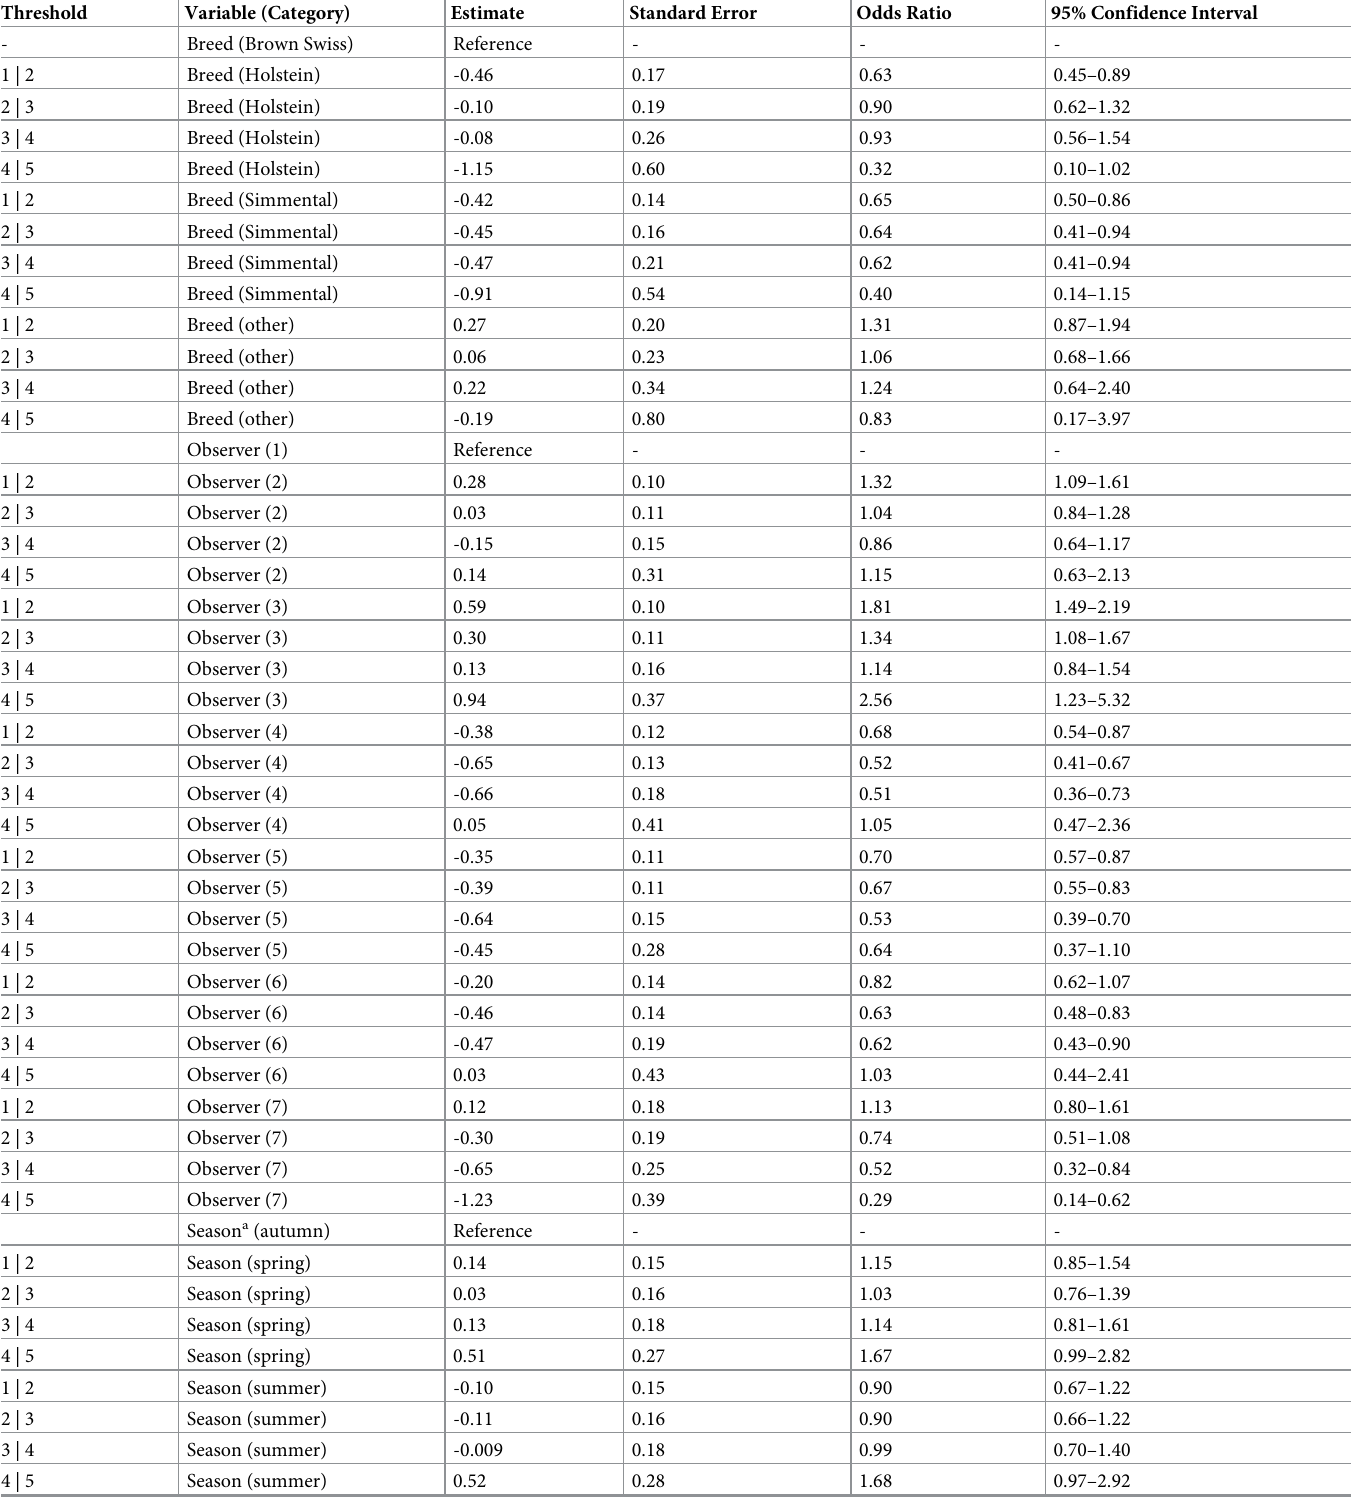
Table 5. Final partial proportional odds model results for increasing locomotion score and variables (breed, observer, season) with relaxed proportional